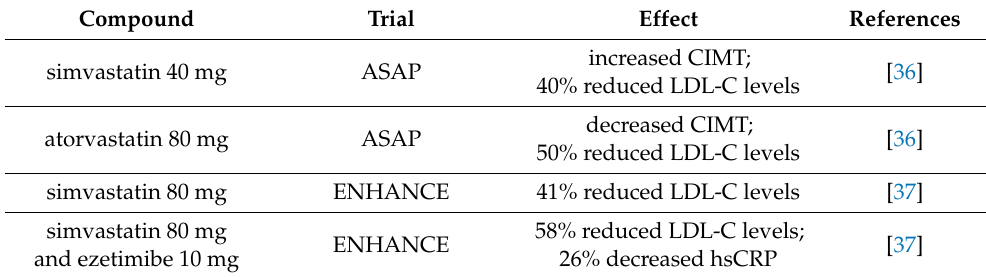
Table 1. Simvastatin and atorvastatin